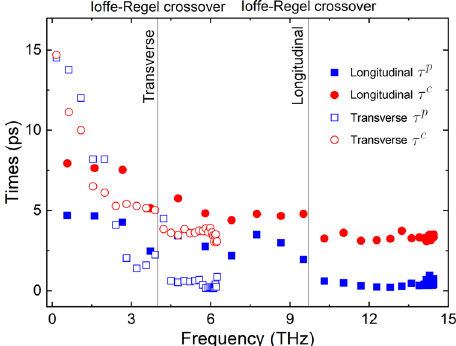
Fig. 4 Calculated lifetime ( τ p ) and coherence time ( τ c ) of amorphous silicon at room-temperature. The vertical lines indicate the Ioffe-Regel crossover for the longitudinal and transverse